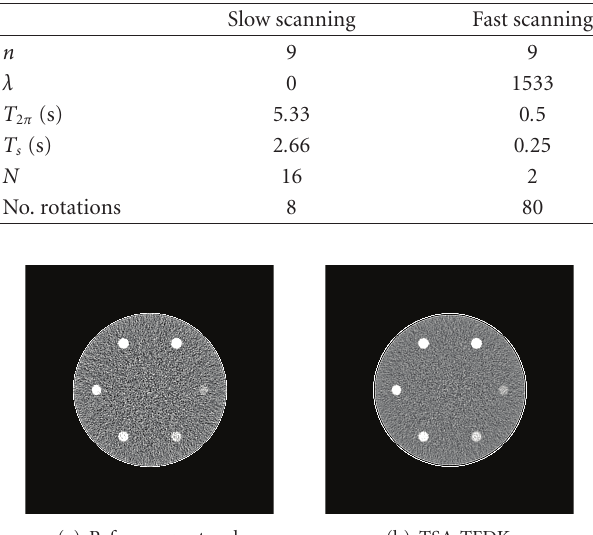
Table 1: Reconstruction parameters for slow and fast scanning reconstruction.